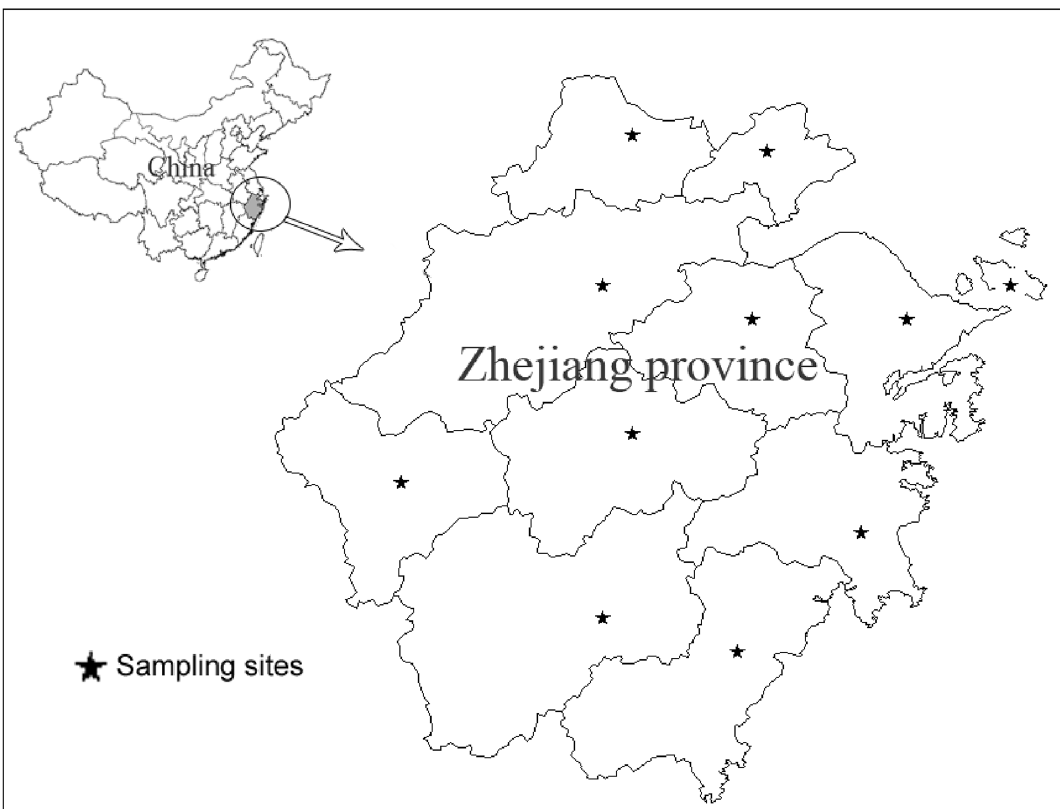
Figure 1. The simple map of sampling areas in Zhejiang province of China.